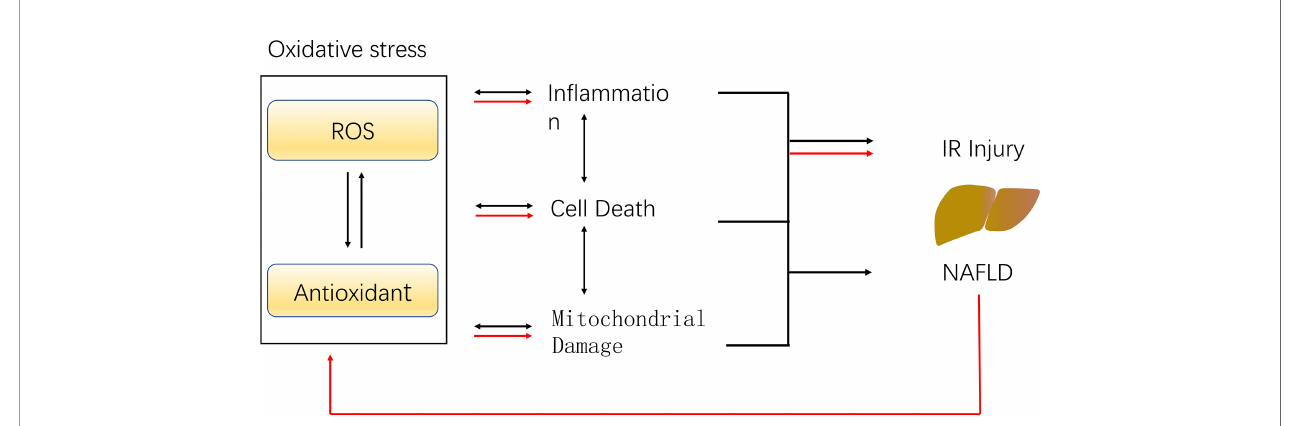
FIGURE 3 | The potential mechanism of IR injury and NAFLD caused by ROS. ROS leads to the inactivation of antioxidants, which reduce the scavenging of ROS, and the imbalance of the ROS and antioxidant results in oxidative stress. Oxidative stress promotes in fl ammation, mitochondrial damage as well as cell death, leading to hepatic ischemia-reperfusion injury and NAFLD (black arrows). The presence of NAFLD resulted in excessive ROS generation during IR, weaker antioxidant capacity, aggravated oxidative stress and enhanced IR injury (red